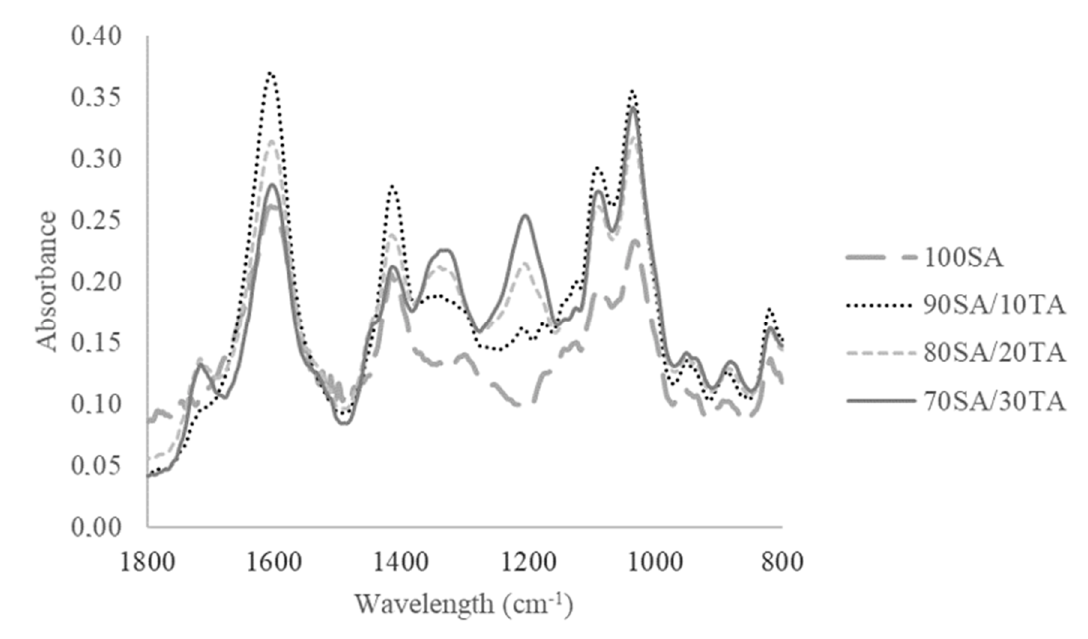
Figure 1. FTIR-ATR spectra of thin films.